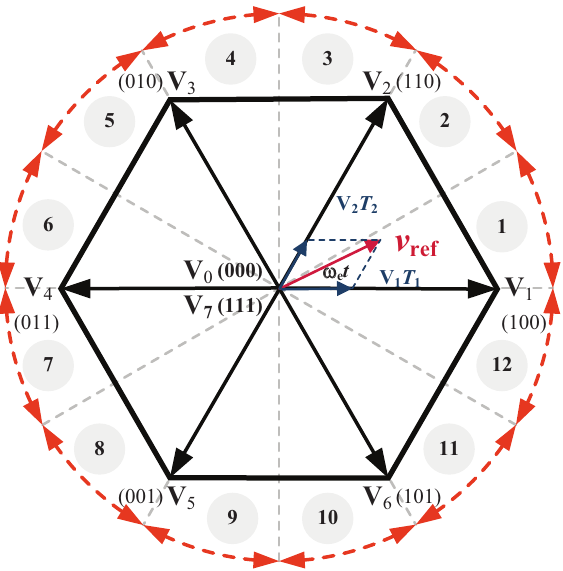
Figure 2. Voltage space vectors of the three-phase two-level